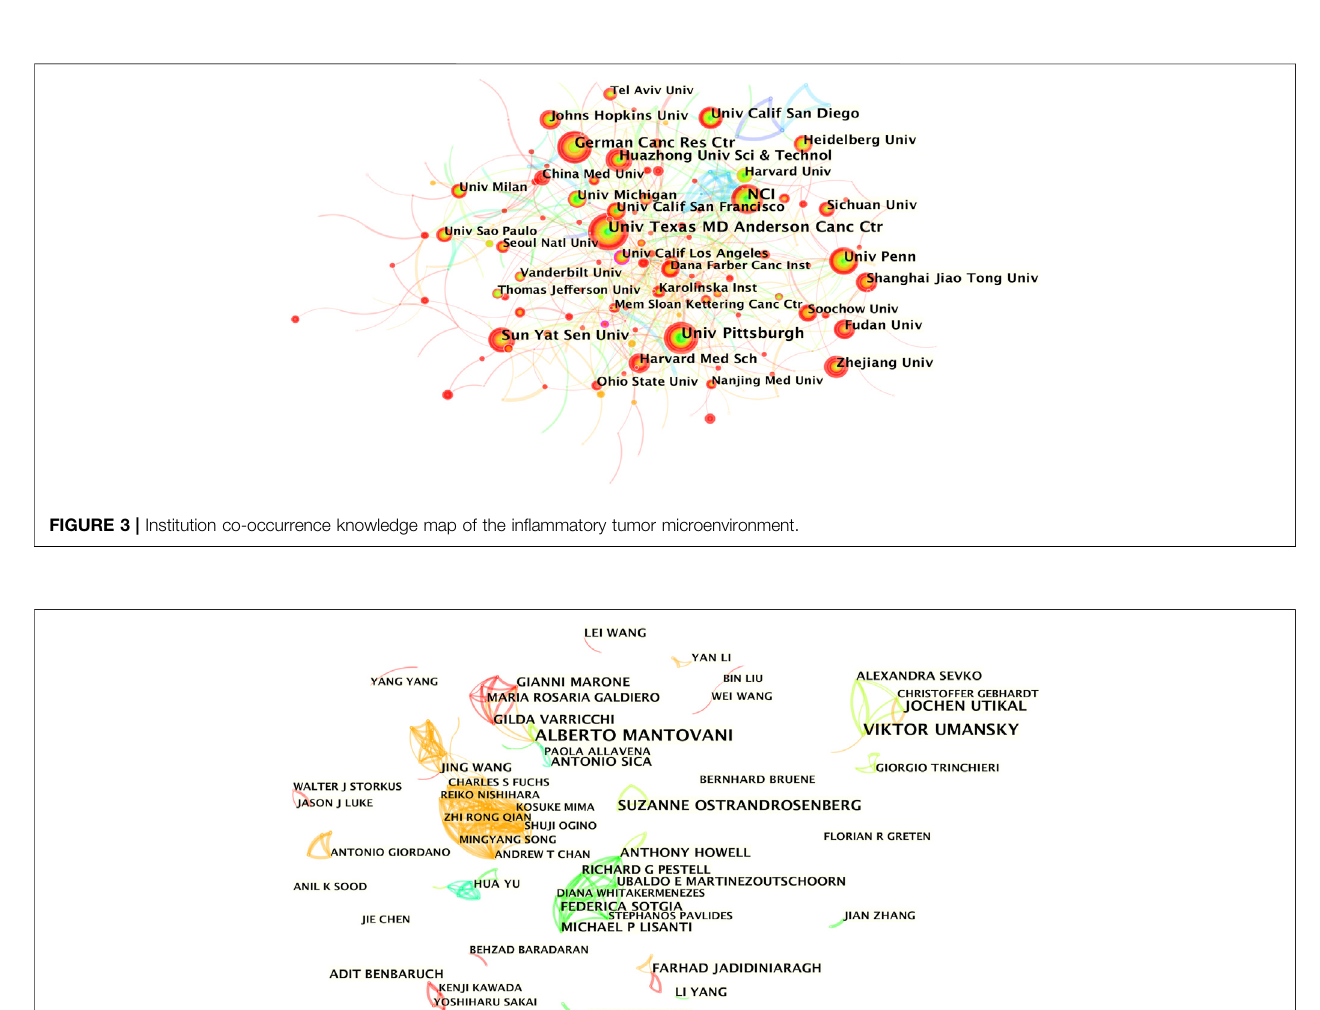
FIGURE 4 | Author co-occurrence knowledge map of the in fl ammatory tumor microenvironment.